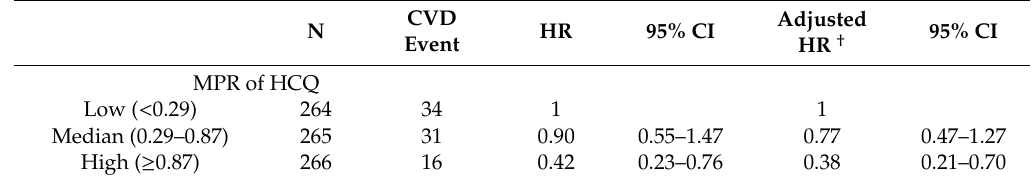
Table 3. High MPR of HCQ was associated with decreasing HR of CVD in SLE